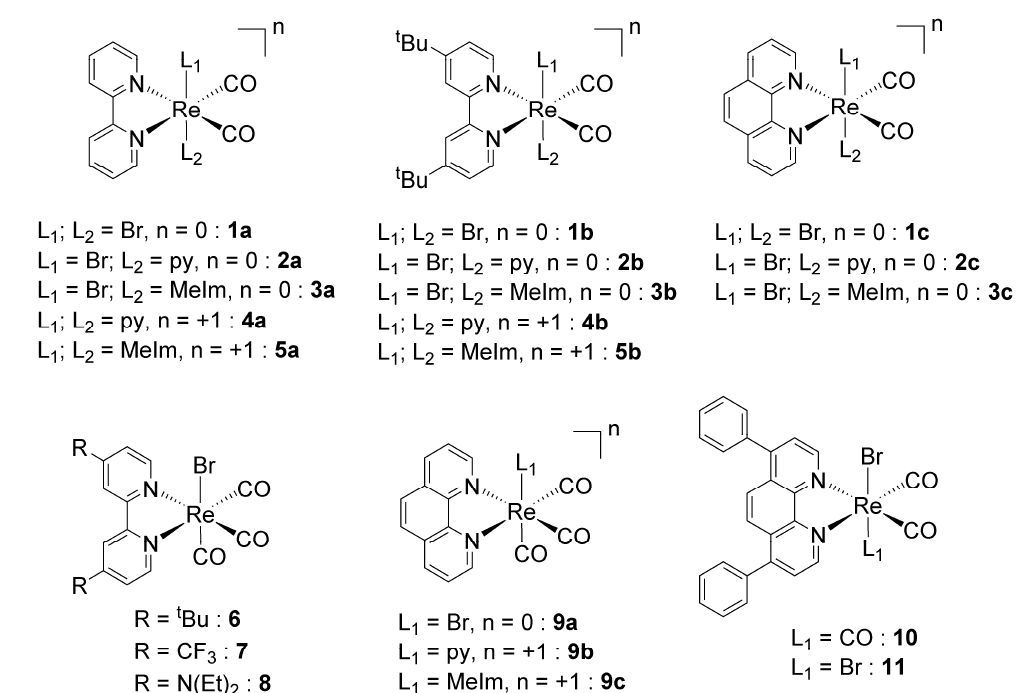
Figure 1. Structures and codes of the tested Re dicarbonyl ( 1 – 5 ) and tricarbonyl ( 6 – 10 )